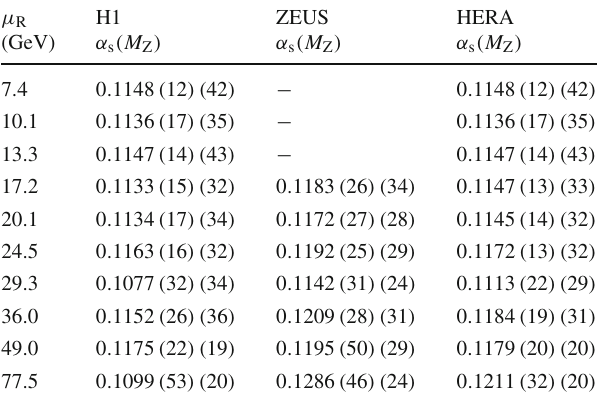
Table 2 Values of the strong coupling constant at the Z-boson mass, α ( M ) , obtained from fits to groups of data with comparable values s Z of μ R . The first (second) uncertainty of each point corresponds to the experimental (theory) uncertainties. The theory uncertainties include PDF related uncertainties and the dominating scale